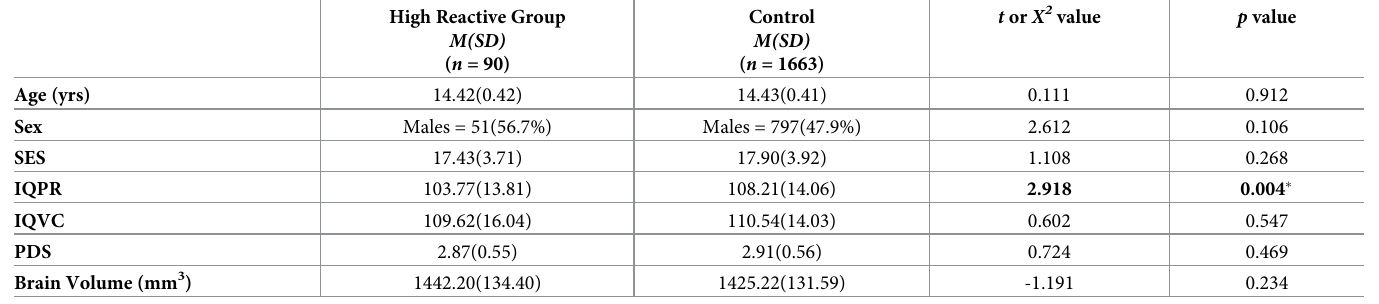
Table 1. Demographic summary. Demographic summary for amygdalar reactivity